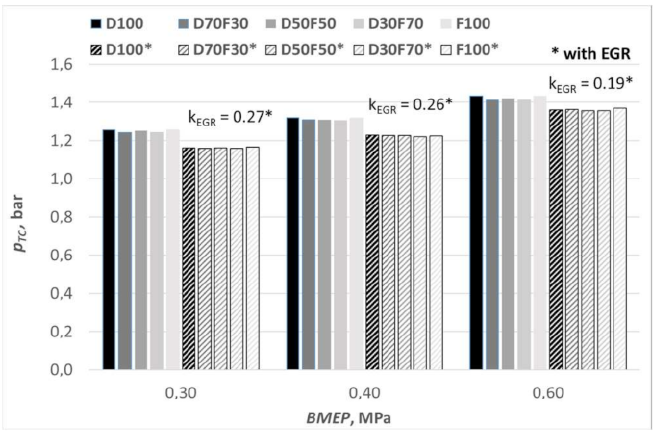
Figure 8. Dependence of turbocharger pressure on fuel composition and engine